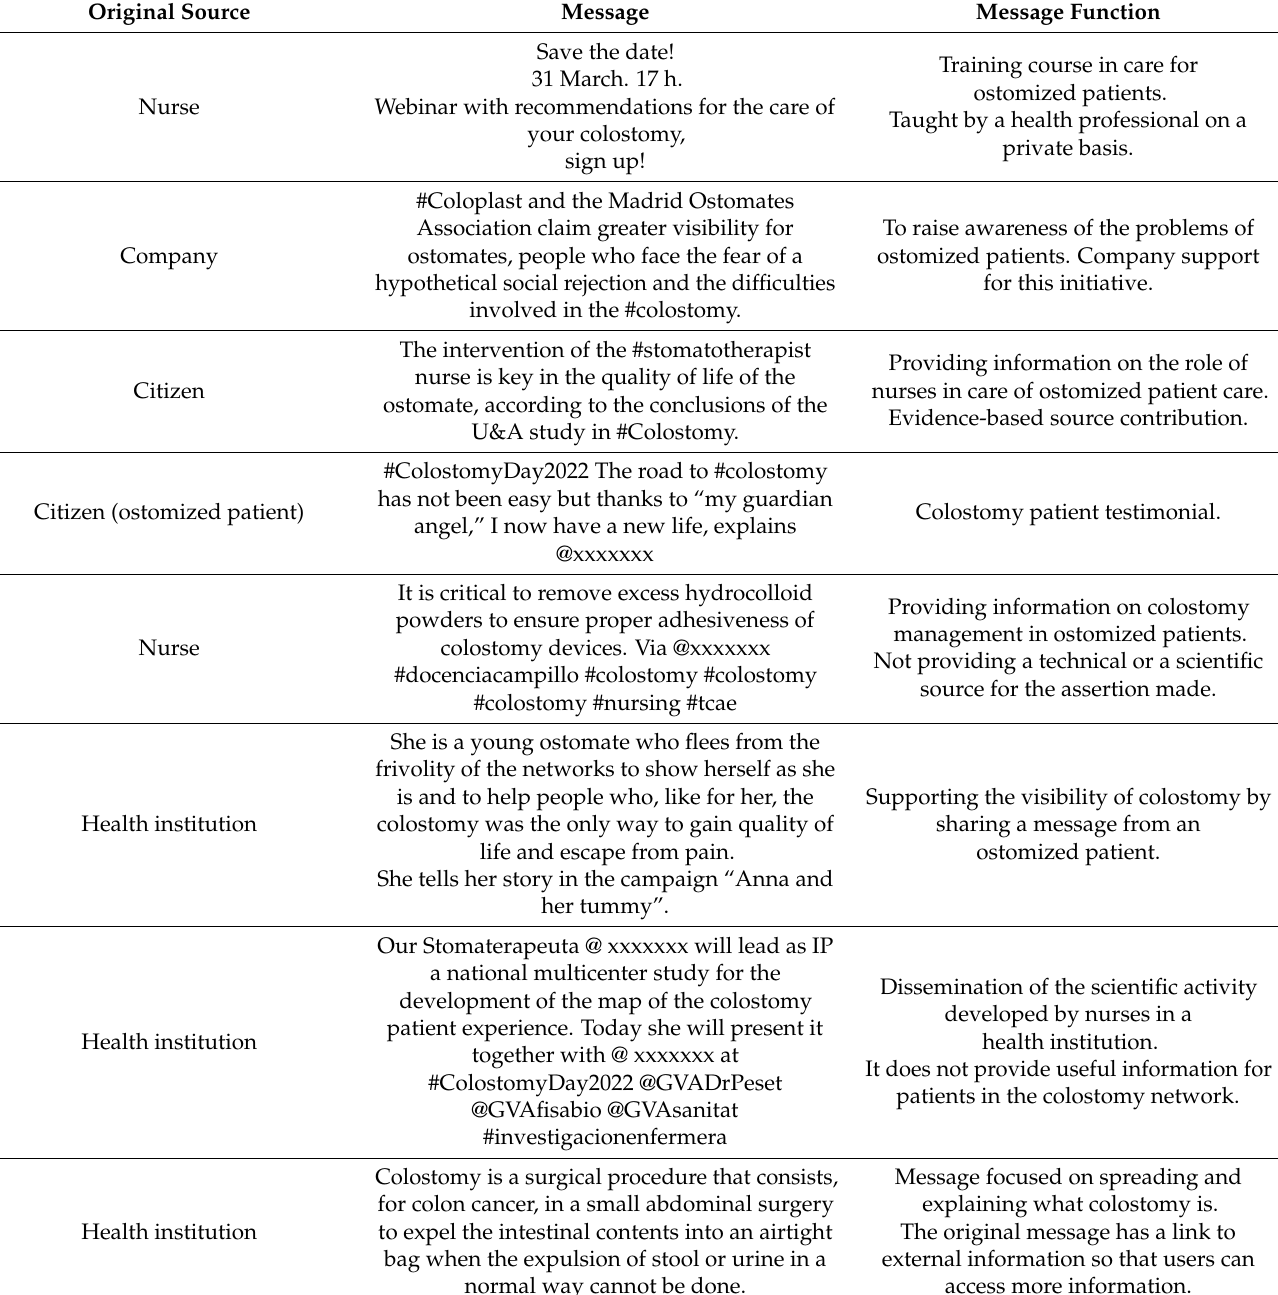
Table 3. Examples of messages by health institutions and nurses in the colostomy